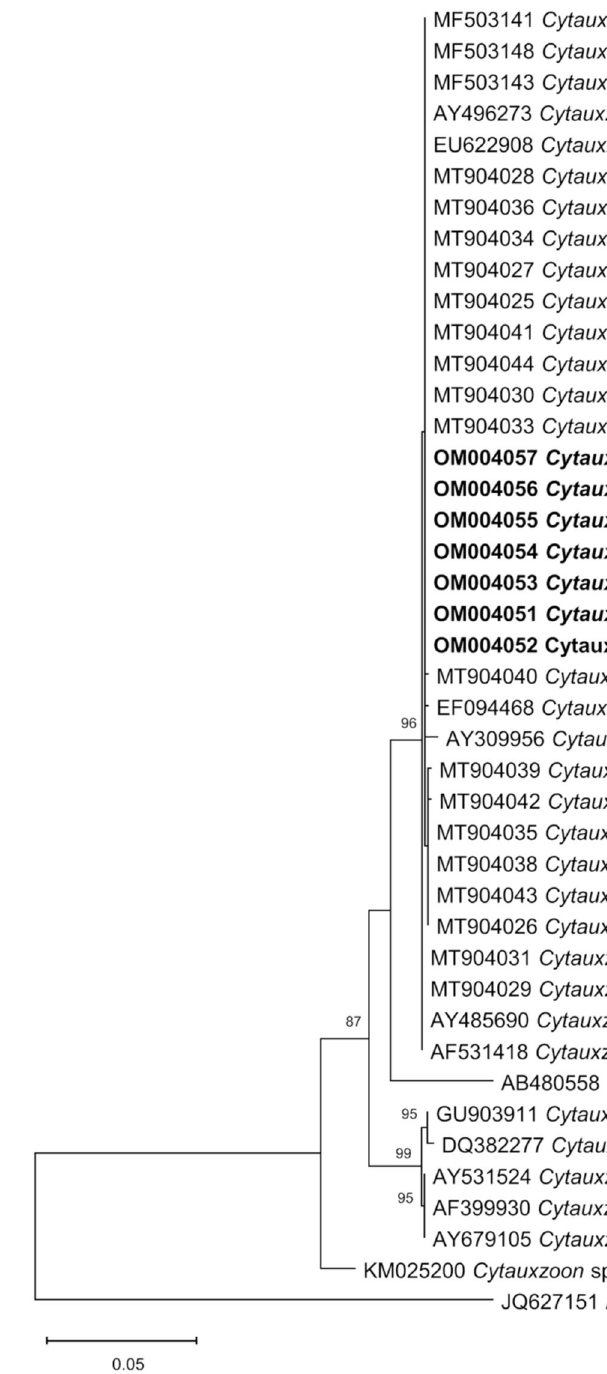
FIGURE4 Phylogenetic relationship of Cytauxzoon spp. inferred from an alignment of 979 sites of the 18S rRNA gene. The maximum likelihood nucleotide tree inferred from an alignment of 979 sites of Cytauxzoon spp. 18S rRNA gene sequences using the Tamura 3-parameter substitution model with discrete gamma distribution. The GenBank accession number, species, host, and country of origin are included for each Cytauxzoon spp. sequence. The nucleotide sequences generated in this study are in bold and marked with a triangle. Plasmodium falciparum was included in the analysis as an out group. Bootstrap values < 70% are indicated in the respective